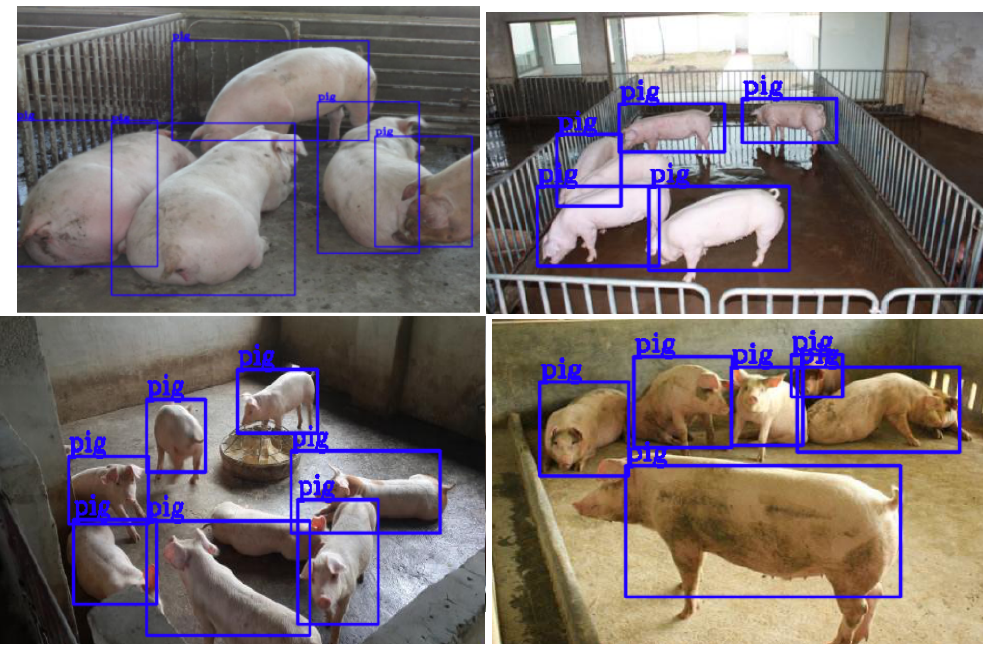
Fig. 6 The results of multiple pig detection.